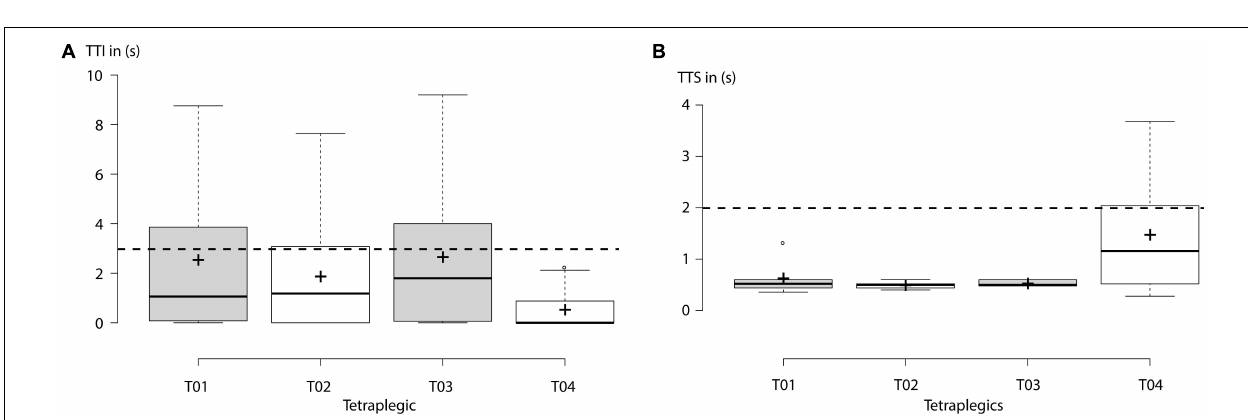
FIGURE 6 | Tetraplegics: (A) “Time to initialize” (TTI) electroencephalography (EEG)-controlled closing motions of the left- or right-hand exoskeleton for each participant. Horizontal dashed line indicates the threshold for the fluency criterion set at 3 s. Average TTI across all subjects ranged below 3 s, documenting fluent control. (B) “Time to stop” (TTS) an ongoing closing motion by using short horizontal oculoversions (HOVs). Horizontal dashed line indicates the threshold for the safety criterion set at 2 s. Only tetraplegic T04 exceeded the threshold of safety criterion. Centerlines of boxplot show the median, while crosses show the mean. Box limits indicate the 25th and 75th